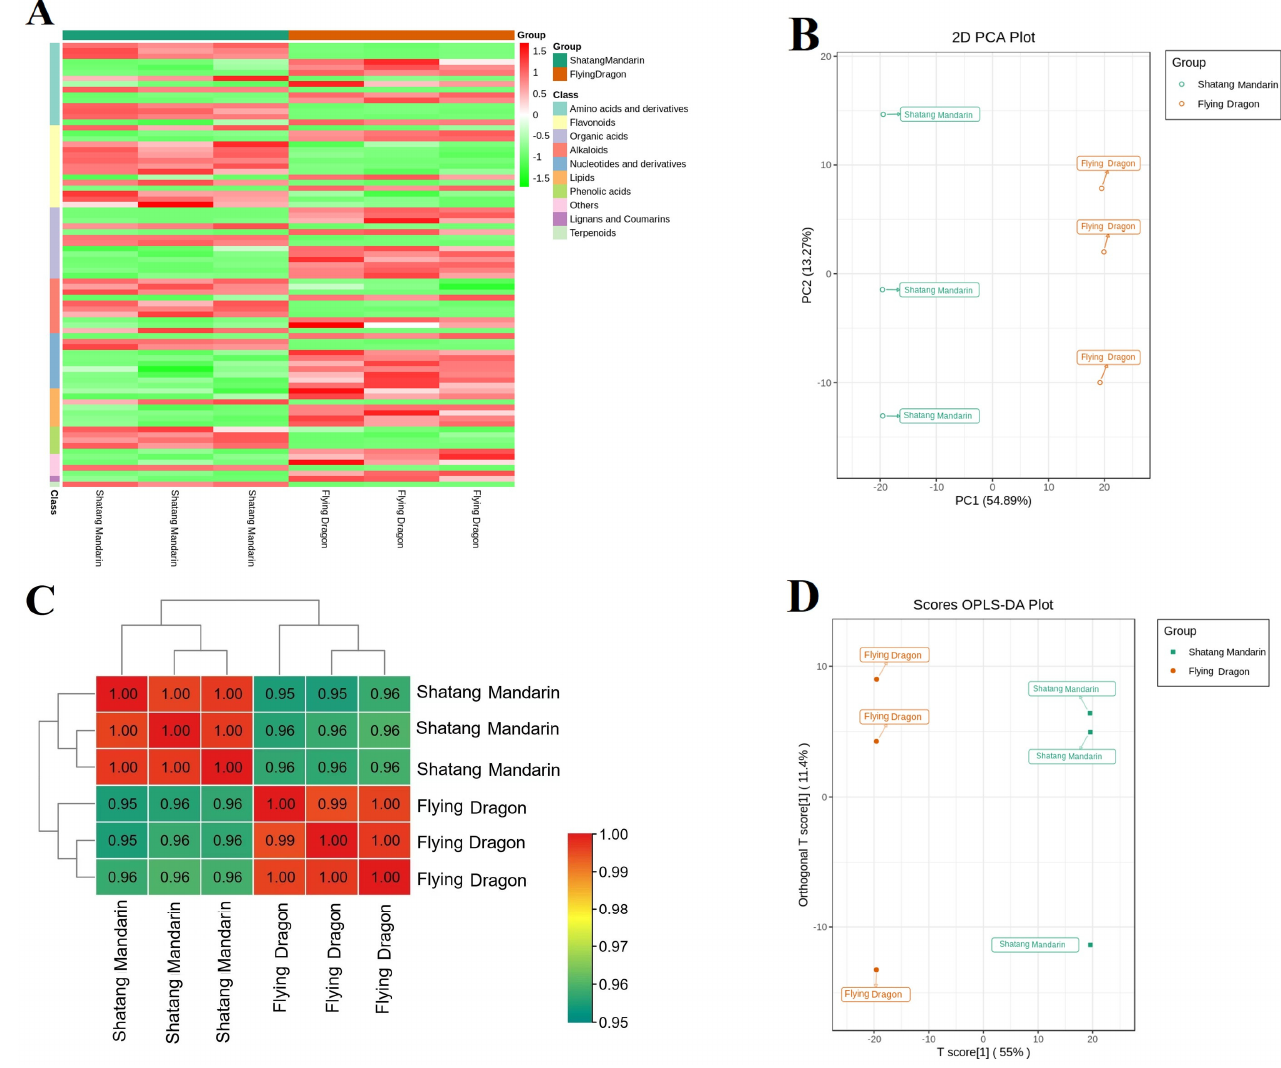
Figure 7. Clustering heat map of all metabolites ( A ). The horizontal axis indicates the name of the samples, whereas the vertical axis displays all metabolites. The red shade shows that the metabolites content in the samples was higher; green shows the lower content of metabolites. ( B ) Score plots of principal component analysis. ( C ) Correlation analysis. ( D ) Score plots of partial least squares discriminant analysis.